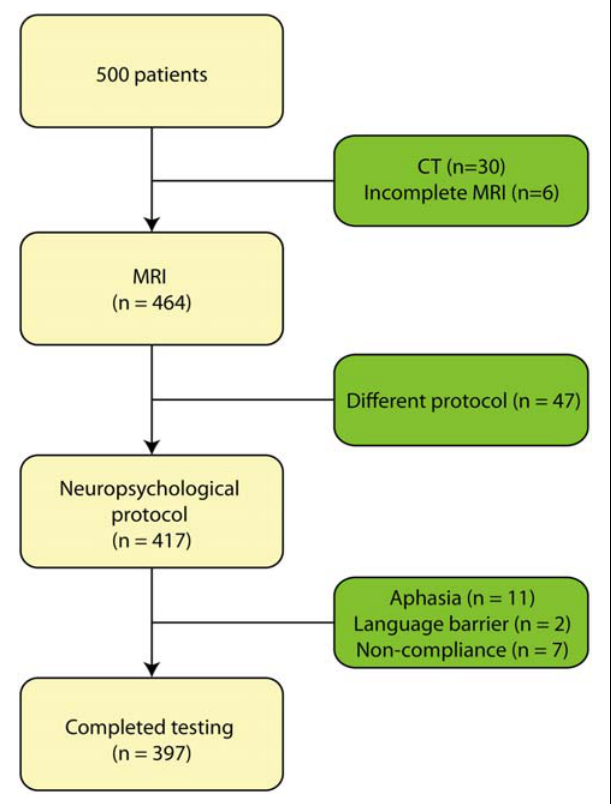
FIGURE 1 | Flowchart of the included